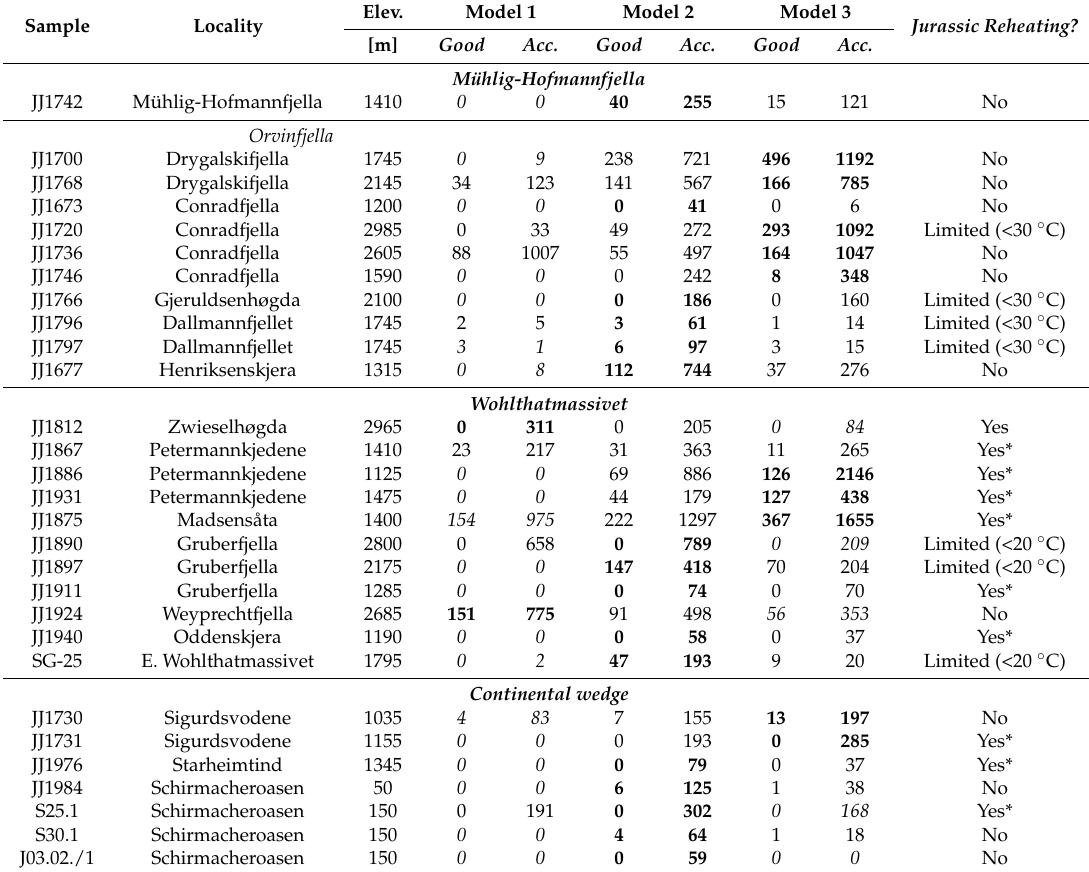
Table footnote: Model 1: Only monotonic cooling. Model 2: Late Paleozoic peneplanation and late Paleozoic—early Mesozoic reburial. Model 3: Late Paleozoic peneplanation and late Paleozoic—early Mesozoic reburial, followed by Late Triassic—Early Jurassic cooling and reburial. Note that samples were not forced to higher temperatures in the Jurassic, merely given the possibility to reheat. Many samples do not show Jurassic reheating when